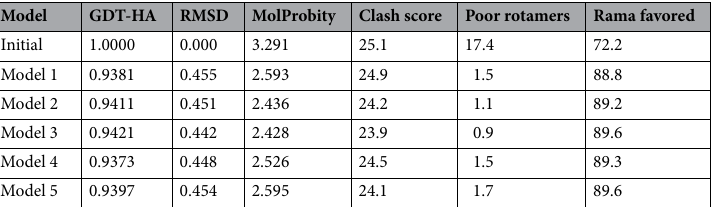
Table 3. Results of the GalaxyRefne server. Model 3 was selected as the best refined model based on the GDT-HA, RMSD, MolProbity, Clash score, Poor rotamers, and Rama favored parameters.